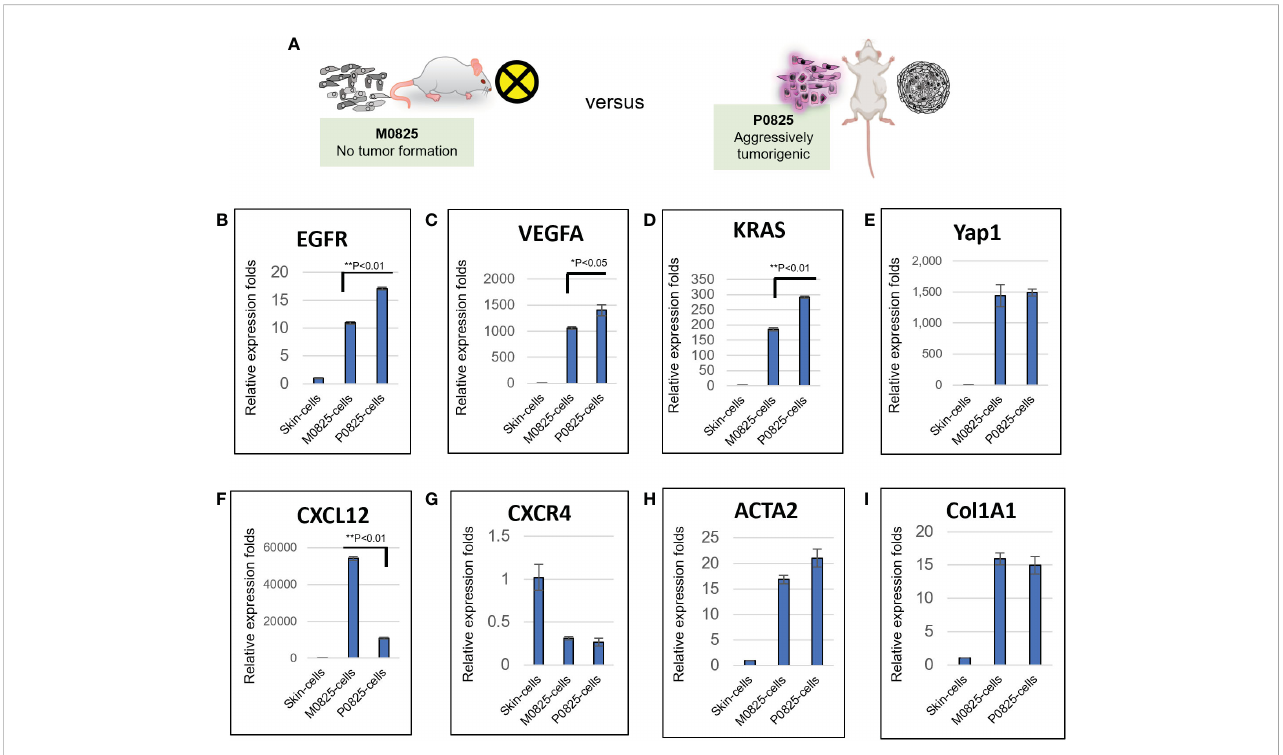
FIGURE 6 mRNA expression pro fi ling and comparison of M0825 cells, P0825 cells and normal skin cells. (A) . An illustration of nontumorigenic M0825 and aggressively tumorigenic P0825. (B – I) . mRNA expression comparisons of growth factors VEGFa and EGFR (B, C) , oncogenes KRas and Yap1 (C, D) , chemokine axis CXCL12- CXCR4 (F, G) , CXCL12 is also a fi broblast and immunity marker. mRNA expressions for fi broblast marker a -SMA and Col1A1 (H, I)